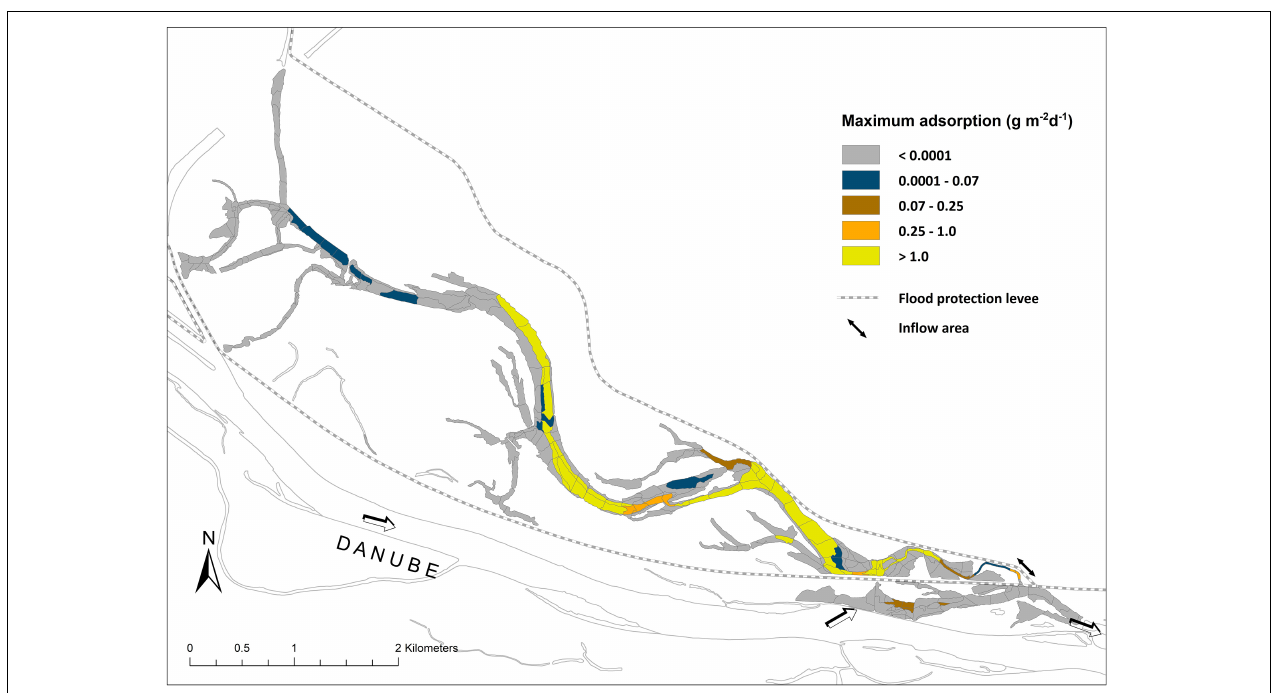
FIGURE 4 | Maximum SRP adsorption potential in different floodplain water bodies under flooding conditions (in g m − 2 d − 1